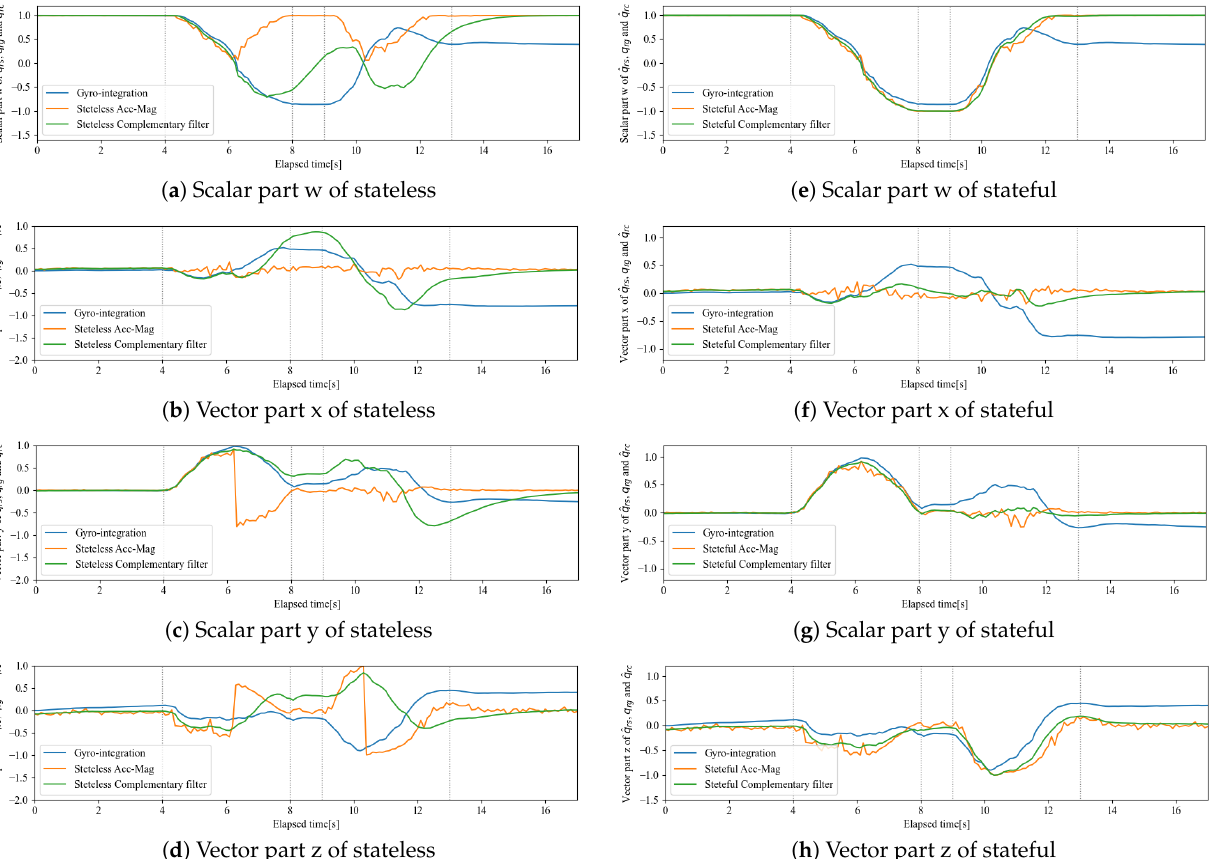
Figure 12. Comparison of sensor fusion results between stateless and stateful